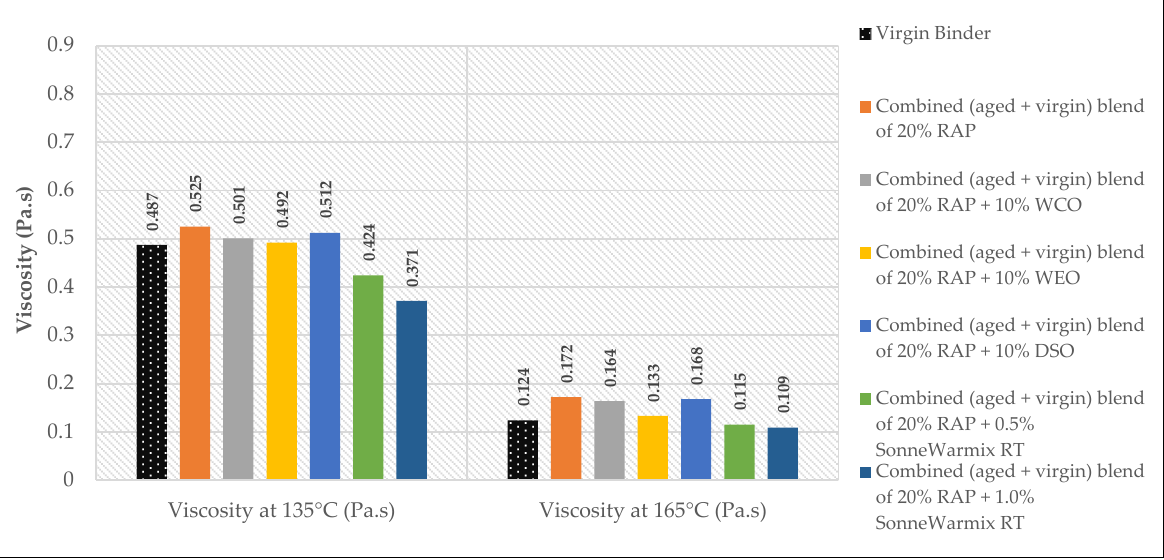
Figure 14. Rotational viscosity of combined (aged + virgin) binder blend of 20% RAP.